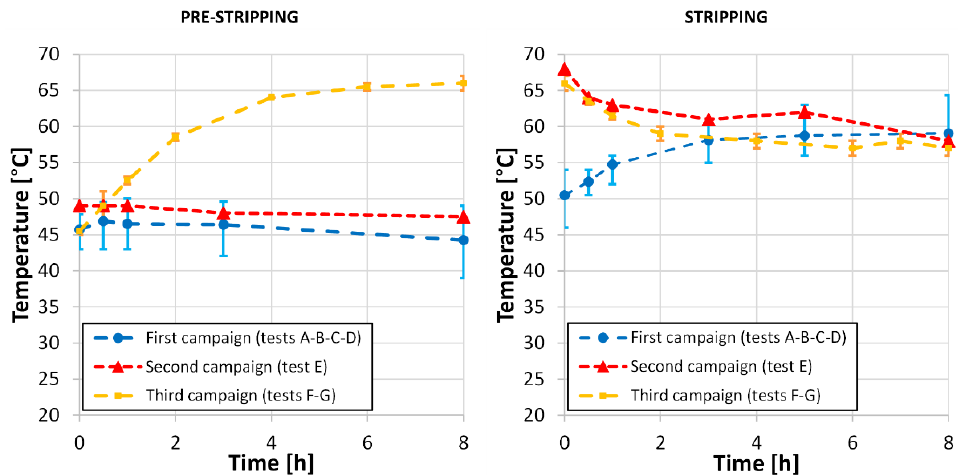
Figure 2. Trend of temperature during the pre-stripping and stripping phases for the three campaigns. Baffles show the variation among tests of the same campaign.